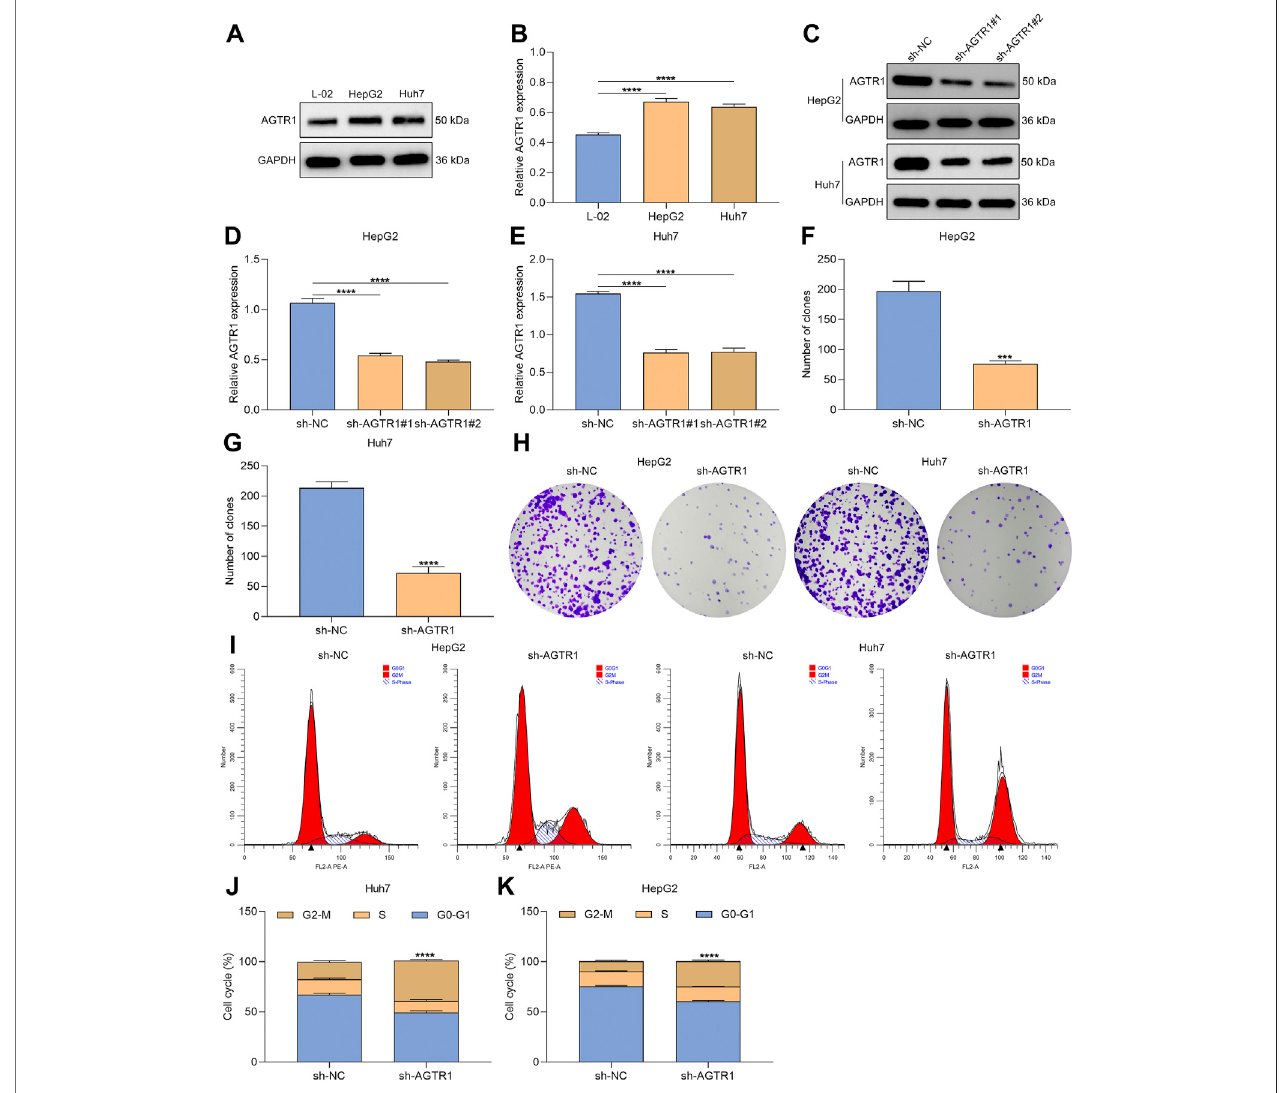
FIGURE 1 | AGTR1 knockdown alleviates proliferation and induces growth arrest for HCC cells. (A,B) AGTR1 protein expression in L-02, HepG2 along with Huh7celllines. (C – E) AGTR1proteinexpressioninHepG2andHuh7celllineswithsh-AGTR1lentivirustransduction. (F – H) NumberofcoloniesinHCCcelllineswithsh- AGTR1 lentivirus transduction. (I – K) Cell cycle distribution of HCC cell lines with sh-AGTR1 lentivirus transduction.